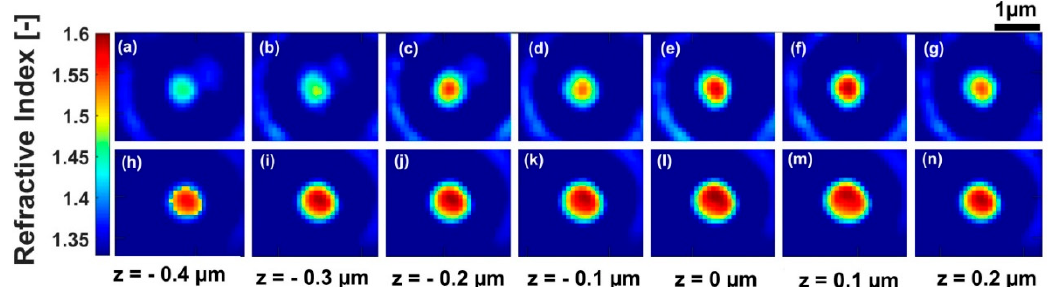
Figure 4. 3D refractive index reconstruction at 640 nm for a polystyrene microsphere with a diameter of 1 µm , without PSF consideration ( a – g ), and with PSF consideration ( h – n ).